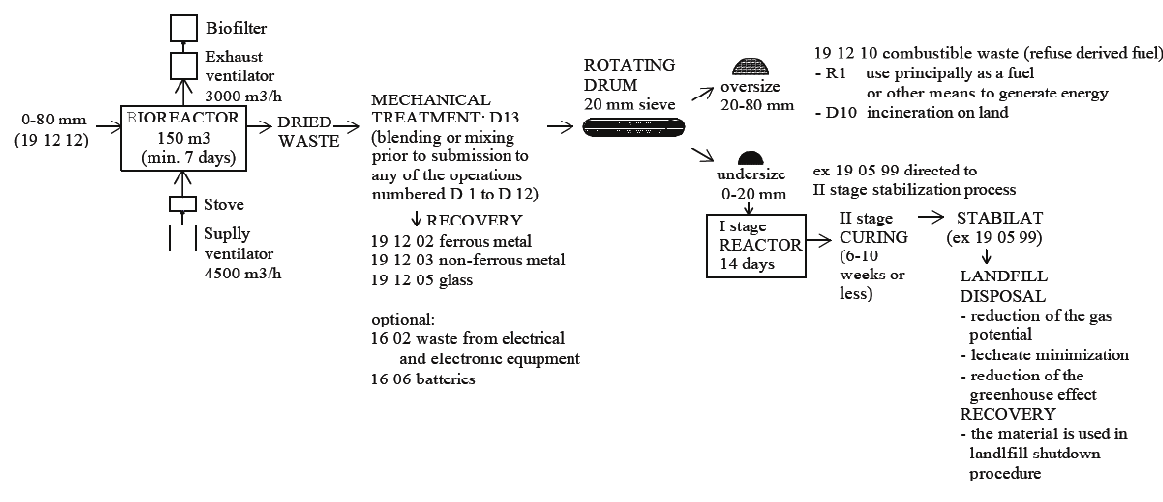
Figure 1: The scheme of the biological stage in an MBT